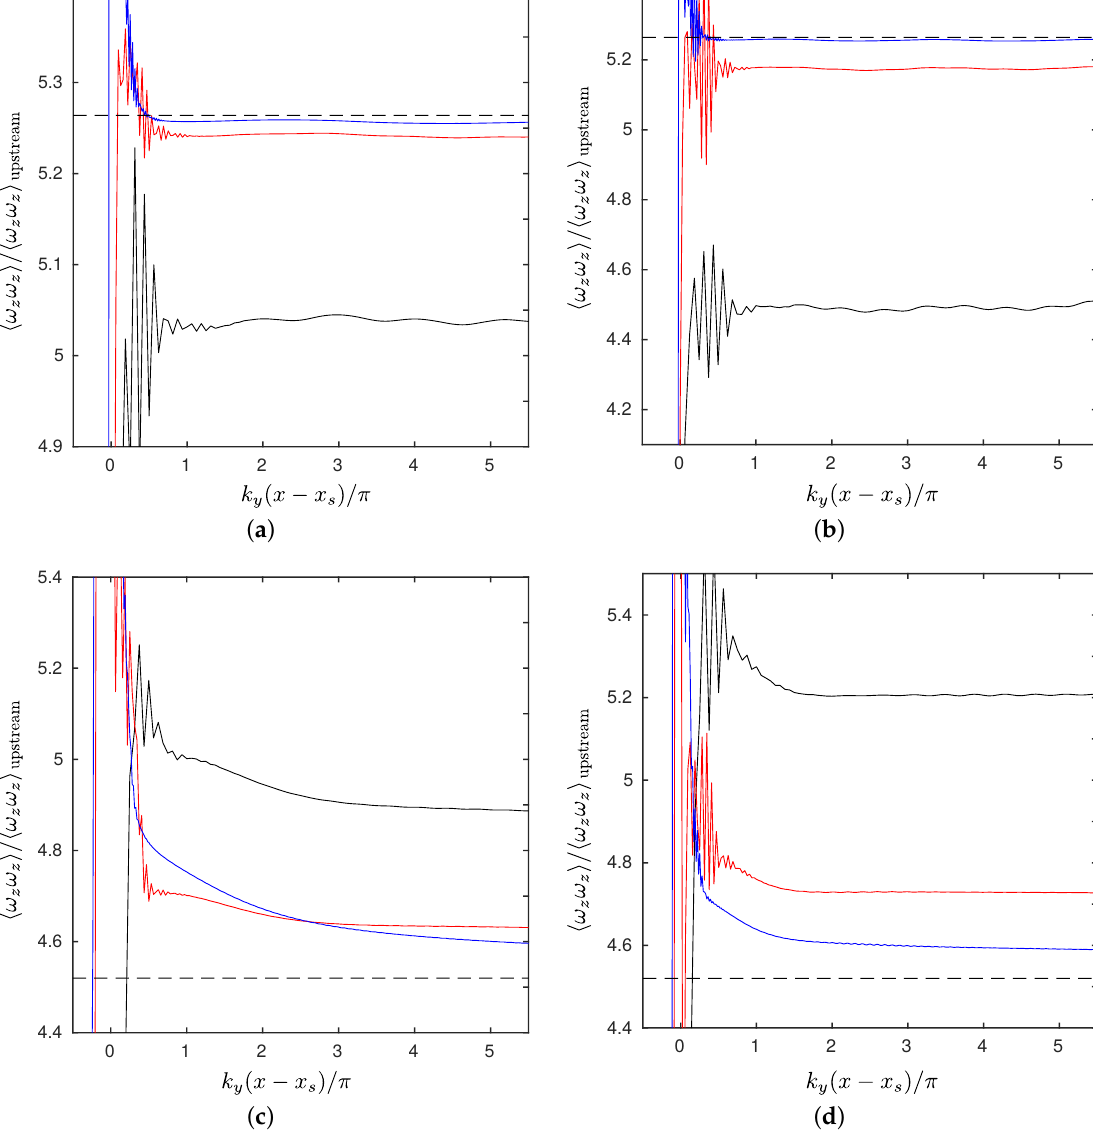
Figure 8. Shock-vorticity/entropy wave interaction. Black dotted line: linear solution; black: grid as in Johnsen et al. [10]; red: medium grid, ∆ x , ∆ y halved; blue: fine grid ∆ x , ∆ y halved again. ( a ) ψ = 45 ◦ , k y = 1; ( b ) ψ = 45 ◦ , k y = 2; ( c ) ψ = 75 ◦ , k y = 1; and ( d ) ψ = 75 ◦ , k y =